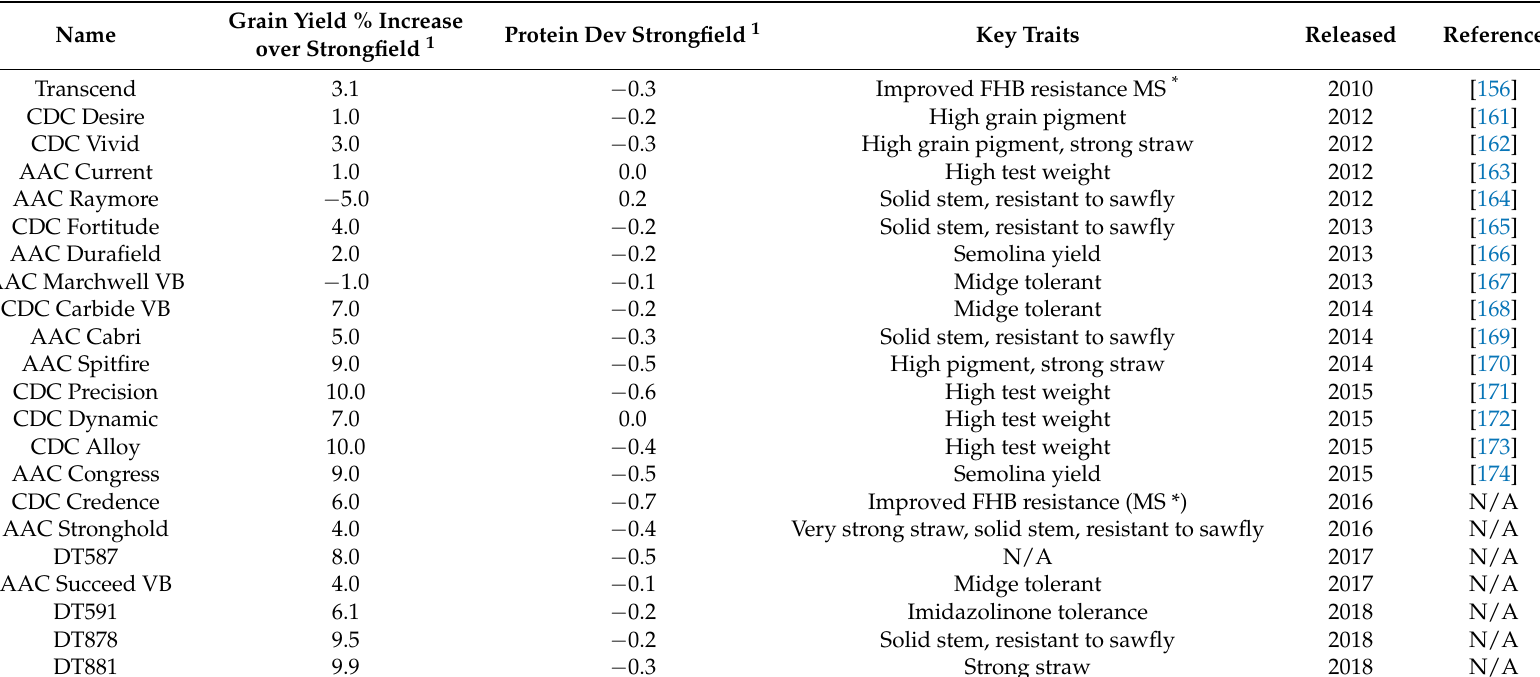
Table 1. Major durum wheat cultivars released since 2010 in Canada, and their yields and protein deviation relative to the check cultivar